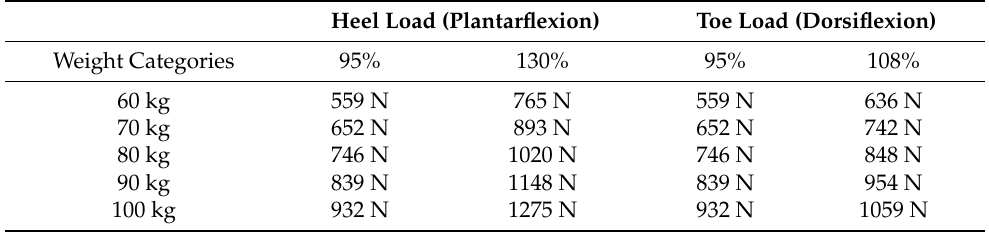
Table 1. Range of heel and toe loads that must ensure a plantarflexion between − 5 ◦ and − 8 ◦ and a dorsiflexion between 14 ◦ and 18 ◦ , respectively, for different weight